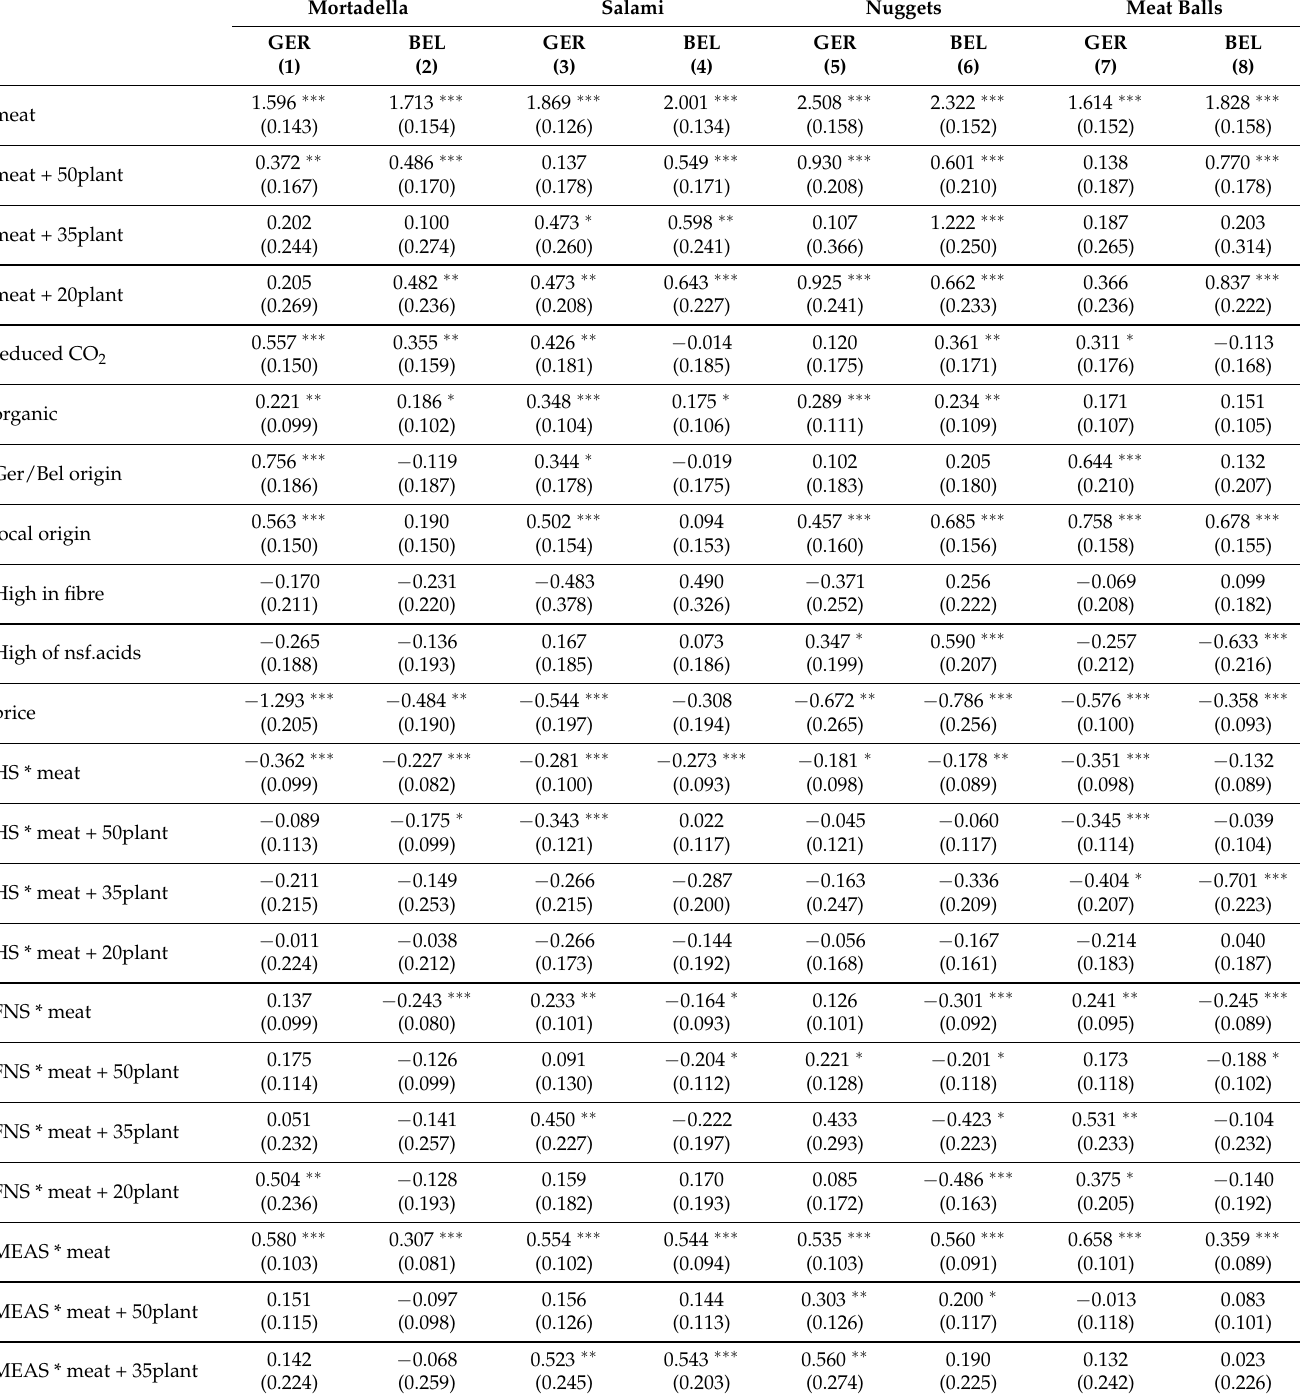
Table 12. Estimation